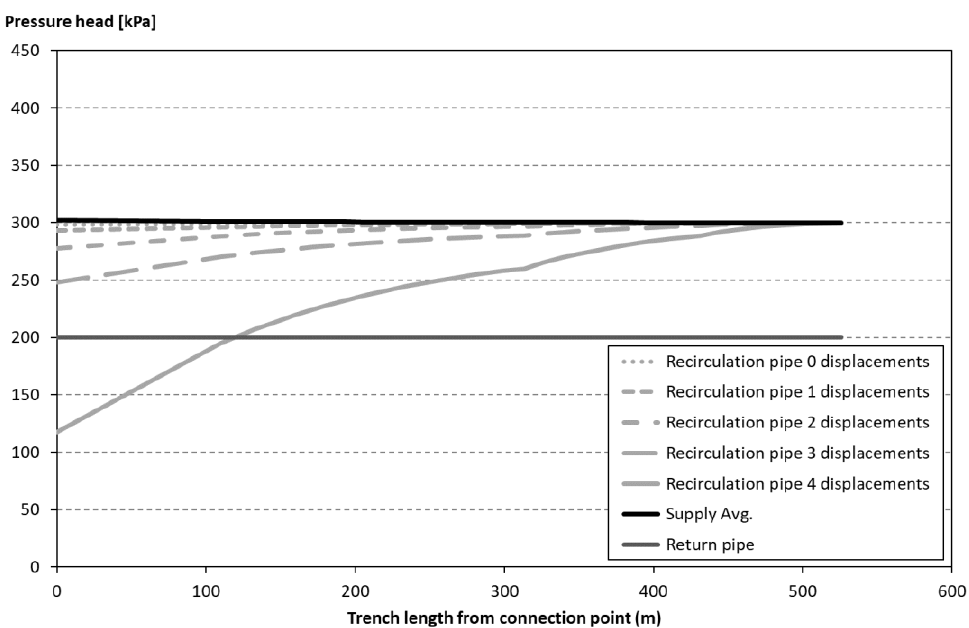
Figure 6. Pressure gradient curve for design conditions (during summer nights) for the longest route in the case area, which is maintained fully by central pumps. Aggregated mass flow rate of 0.93 kg/s. Mass flow rate of return pipe is zero.